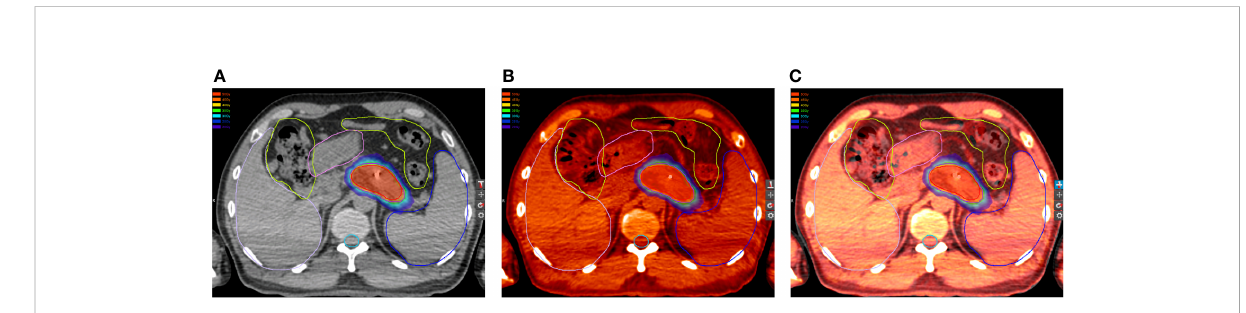
FIGURE 1 Organs at risk (OARs) in the (A) fi rst and (B) second plan. (C) OARs in the fi rst plan projected to the second